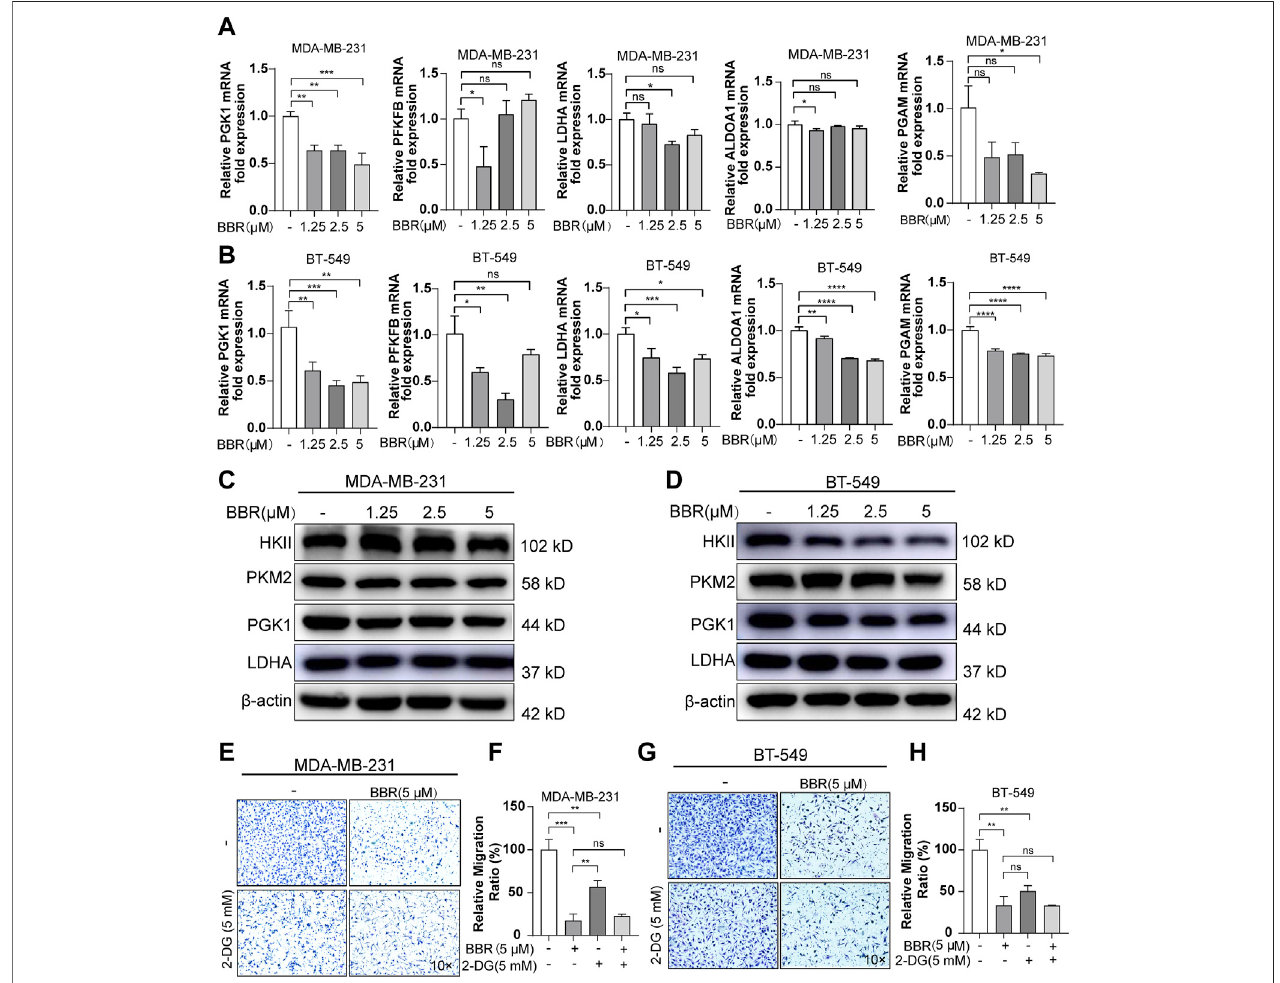
FIGURE 3 | Berberine suppresses aerobic glycolysis thus inhibiting the migration of TNBC cells. (A – B) The mRNA levels of PGK1, LDHA, PFKFB, ALDOA1, and PGAMintheTNBCcellsafterberberinetreatmentfor48 h.Thedatawerenormalizedto β -actinexpression. (C – D) .ProteinlevelsofHK2,PKM2,PGK1,andLDHAinthe TNBC cells after berberine (1.25, 2.5, 5 μ M) treatment for 48 h β -actin was used as a loading control. (E – H) Representative images of MDA-MB-231 or BT-549 cells were pretreated with or without 2-DG (5 mM) for 6 h, then the cells were treated with berberine (5 μ M) for another 48 h, following which the cells were collected for the migration assay. 10 × scale bars, 200 μ m. The data are presented as the mean ± SD of three independent measurements. * p < 0.05, ** p < 0.01, *** p < 0.001 vs.